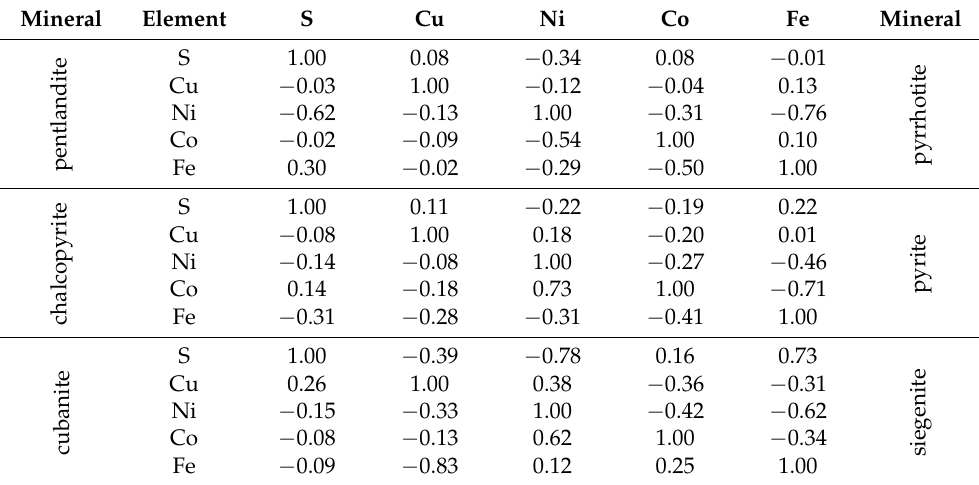
Note: Pearson’s correlation was based on EPMA in pentlandite ( n = 45 measurements), pyrrhotite ( n = 61), chalcopyrite ( n = 50), pyrite ( n = 37), cubanite ( n = 10), and siegenite ( n = 16). Coefficients with absolute values greater than 0.28 are statistically significant at the 95% level.